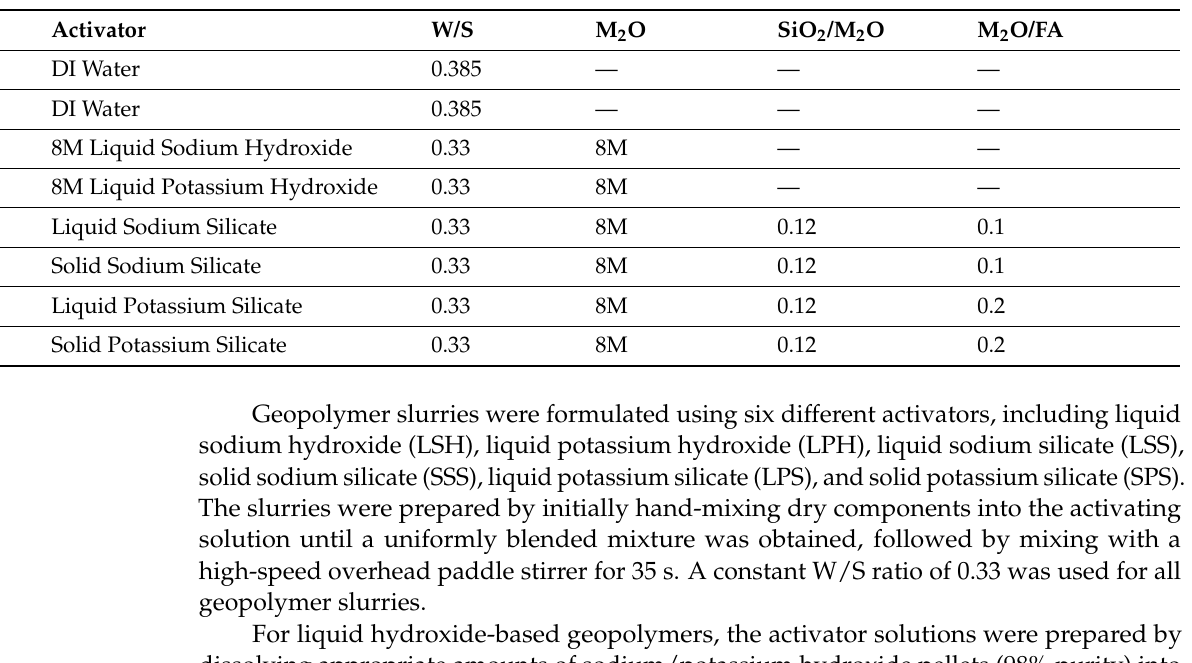
Table 2. Mix design parameters of OPC and geopolymer